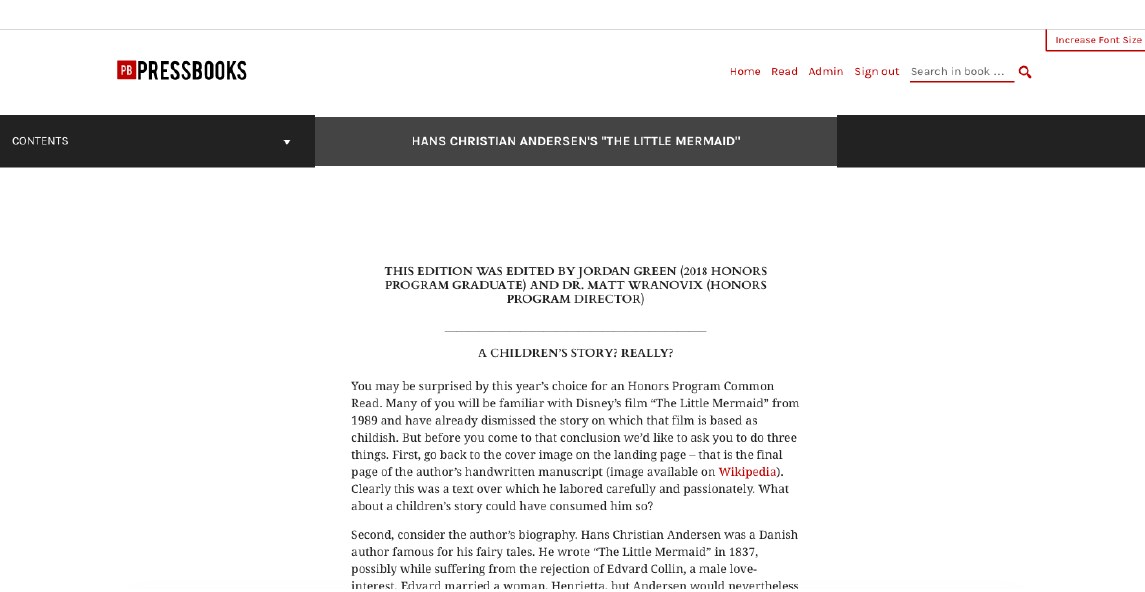
Figure 3. Landing Page for 2018 Honors Program Common